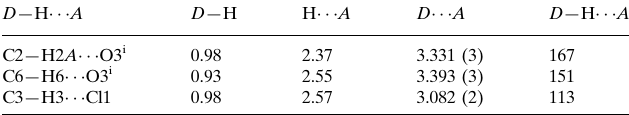
Hydrogen-bond geometry (A˚ , (cid:2)